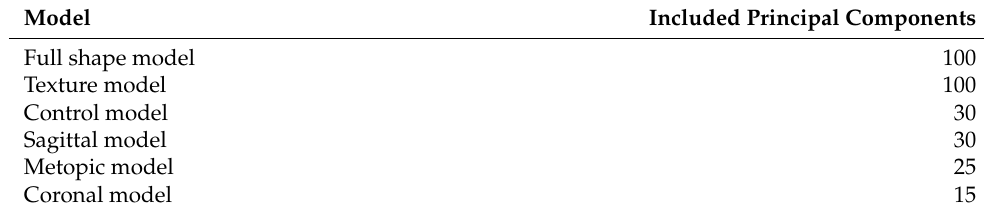
Table 3. Number of principal components included in the publicly available shape model data under Creative Commons license CC-BY-NC